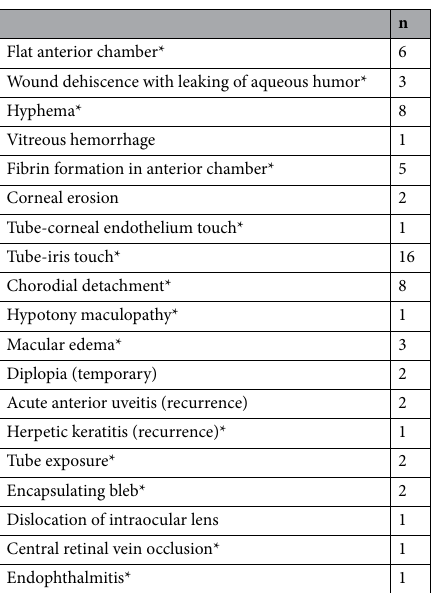
Table 6. Postoperative complications after BGD implantation surgery. BGD, Baerveldt glaucoma device. * includes two or more complications in the same